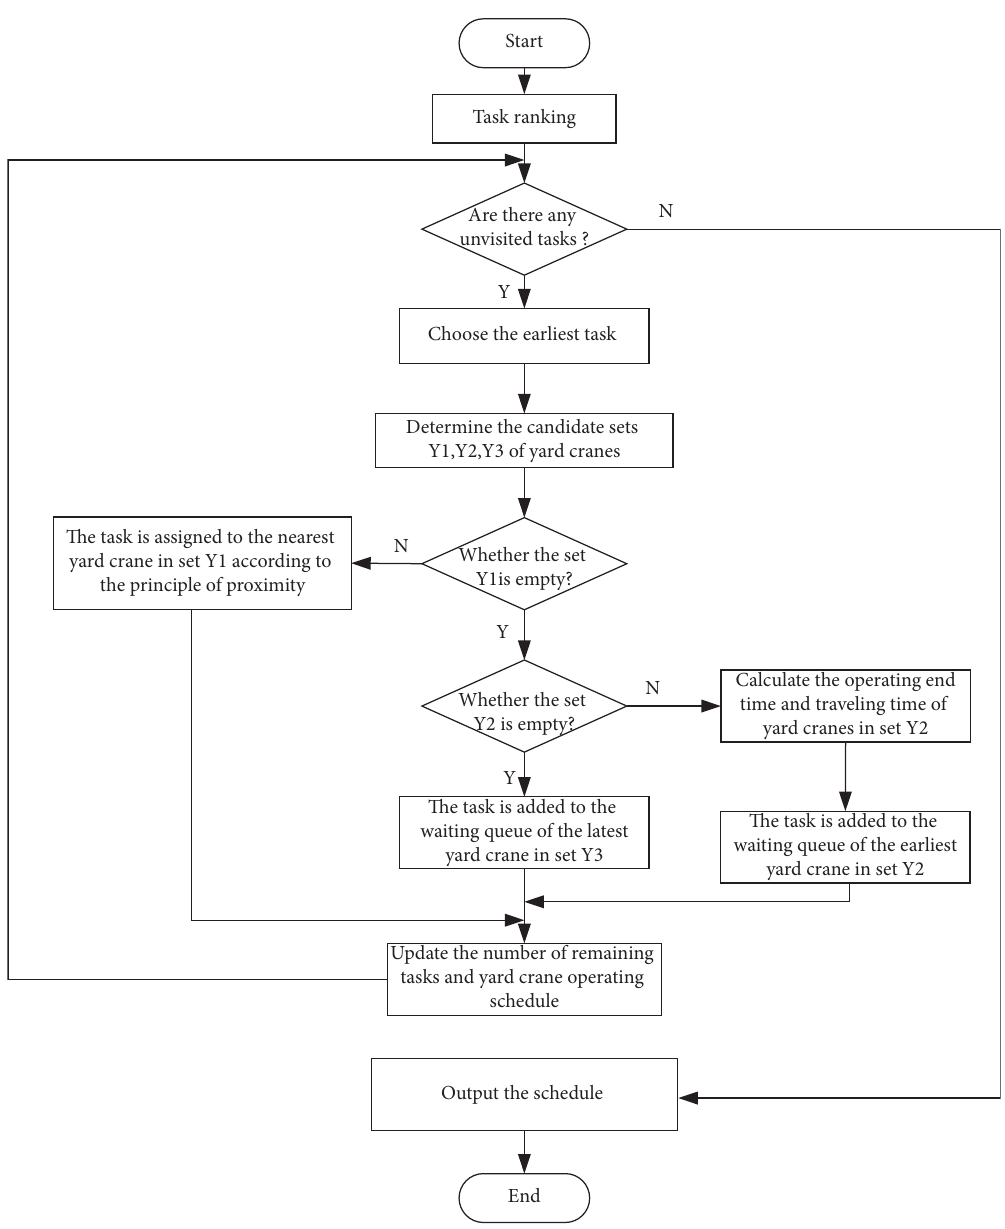
Figure 5: The algorithm process of the principle of proximity